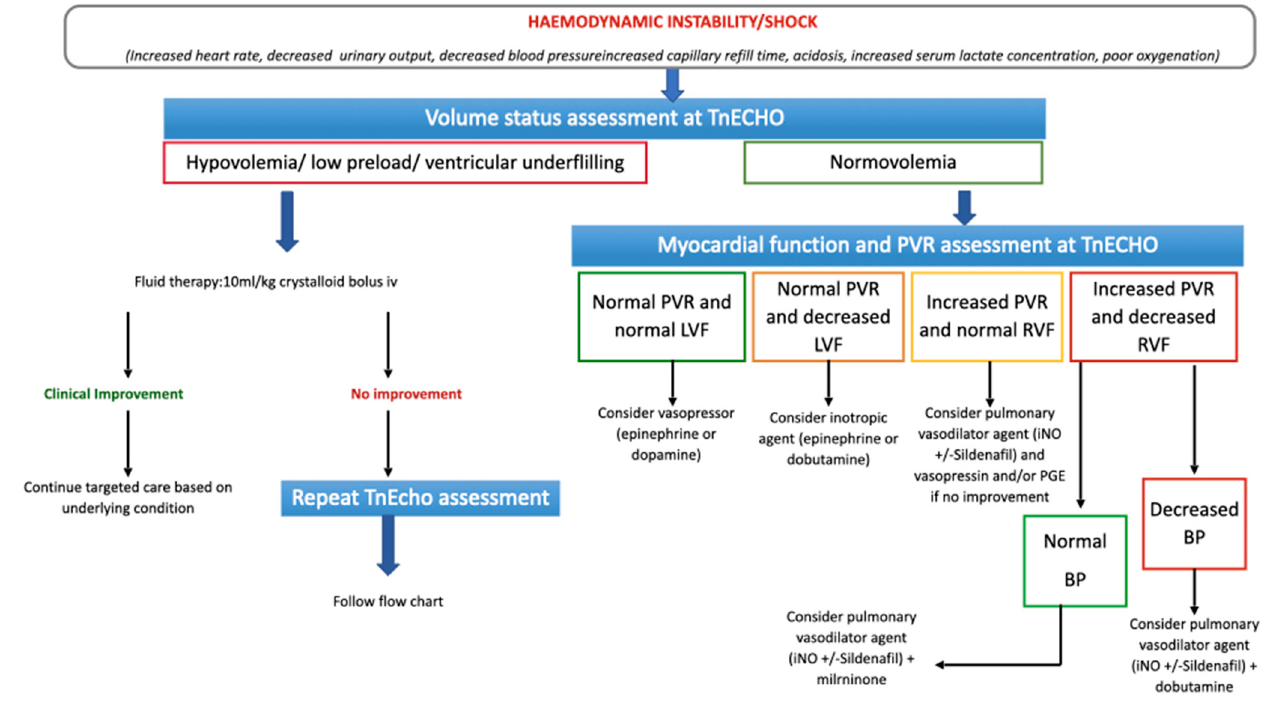
Figure 1. Targeted Neonatal Echocardiography (TnECHO) guidance for neonatal shock. Abbreviations: intravenous (iv); pulmonary vascular resistances (PVR); left ventricular function (LVF), right ventricular function (RVF); inhaled nitric oxide (iNO); prostaglandins (PGE), blood pressure